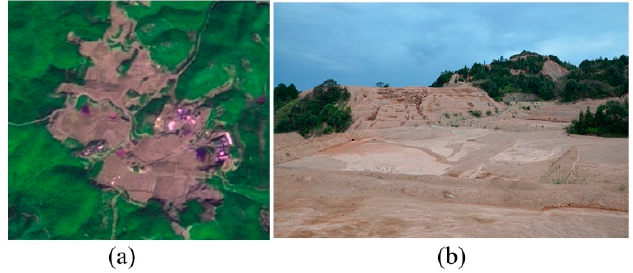
Figure 6. REO mining area field investigation photo. ( a ) GF-1 image; ( b ) REO mining area field photo.